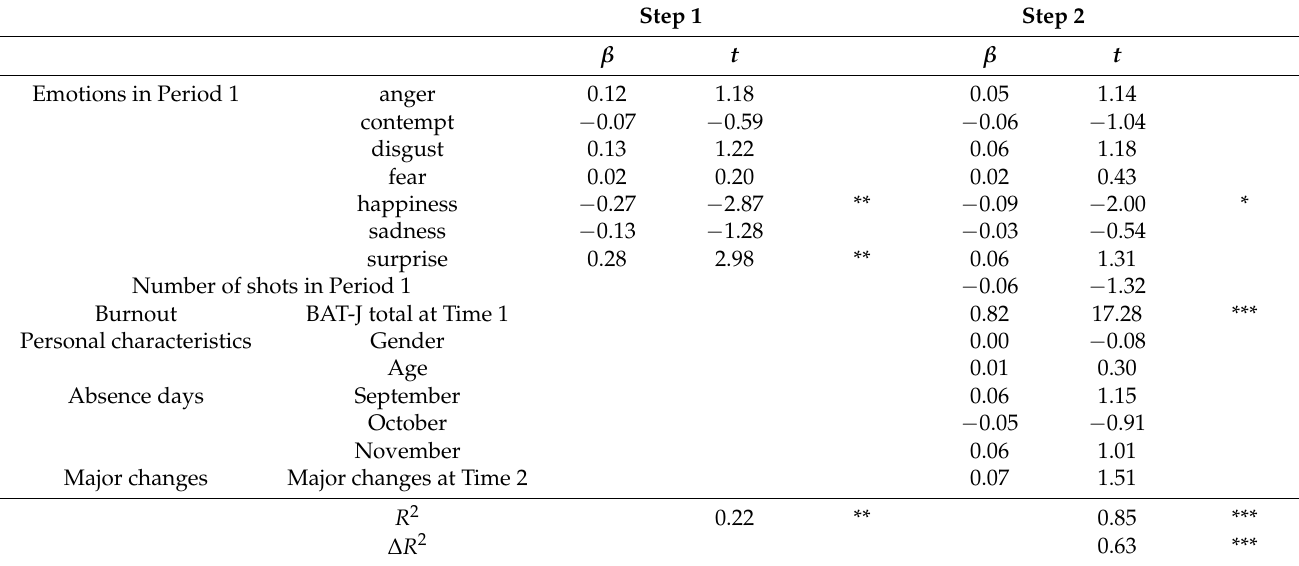
Table 5. Results of hierarchical multiple regression analysis for burnout at Time